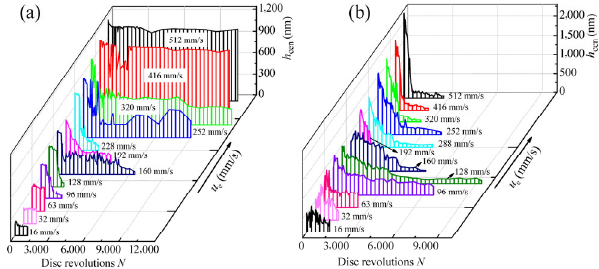
Fig. 8 Comparisons of film evolutions between (a) Grease A and (b) Grease B.